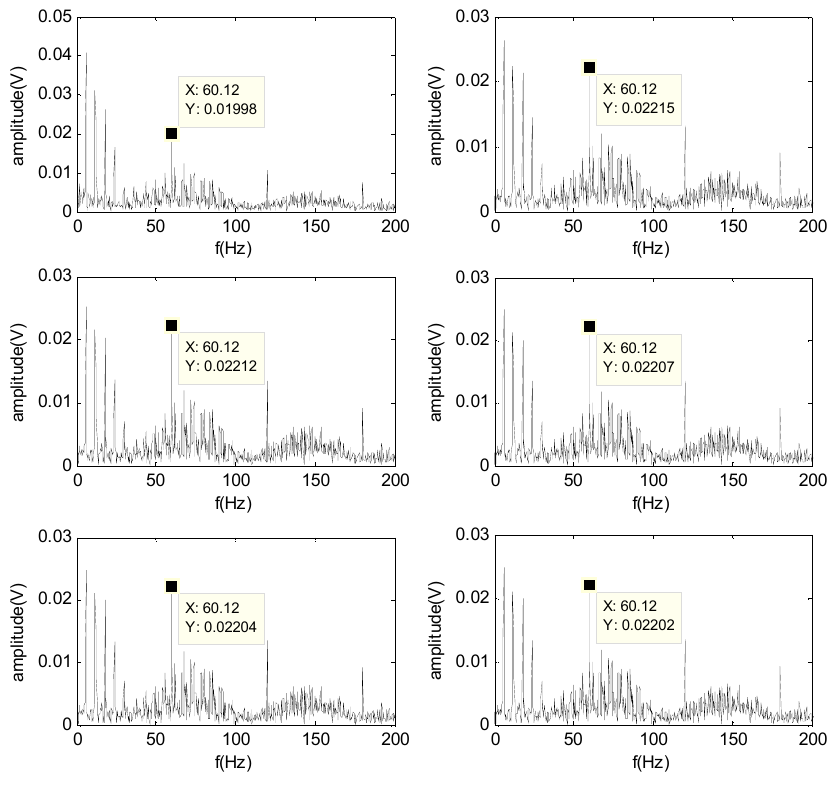
Figure 9. Envelope spectrum of BLIMF1–BLIMF6.